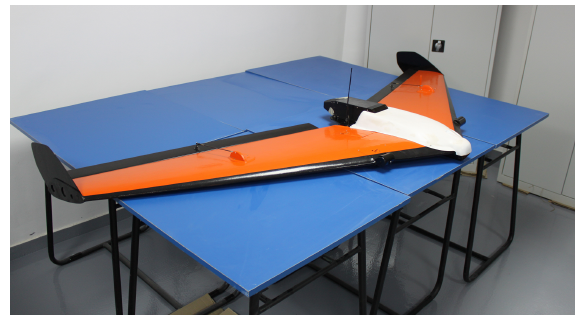
Figure 3. The 2.5m wingspan flying-wing UAV developed in par- allel with